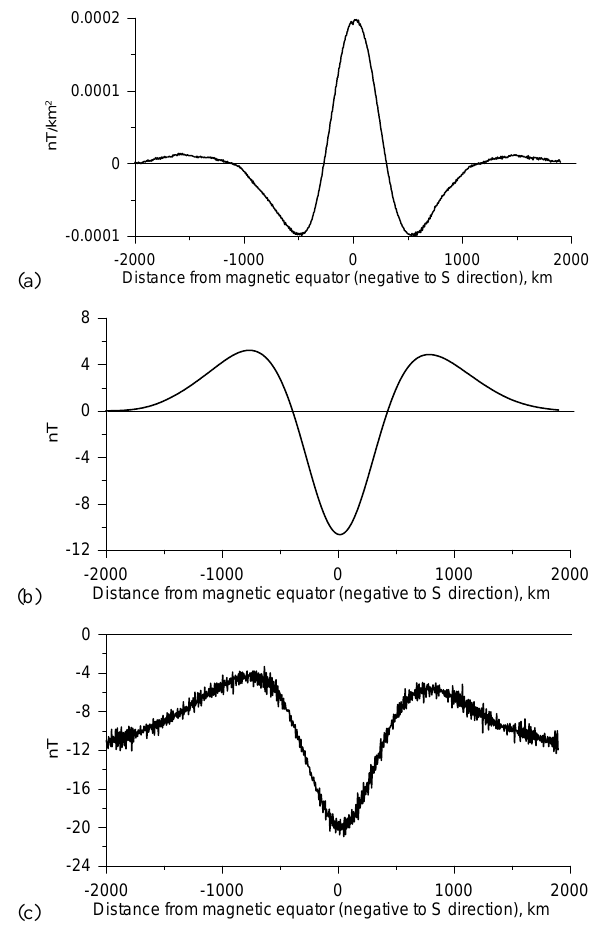
Fig. 6. Profile normal to the dip equator of the equatorial electrojet field, longitudinal component, using a step of 5 km: along track second derivative, in nT/km 2 (a); twicely integrated along track second derivative, in nT (b); original signal, before treatment, in nT (c).